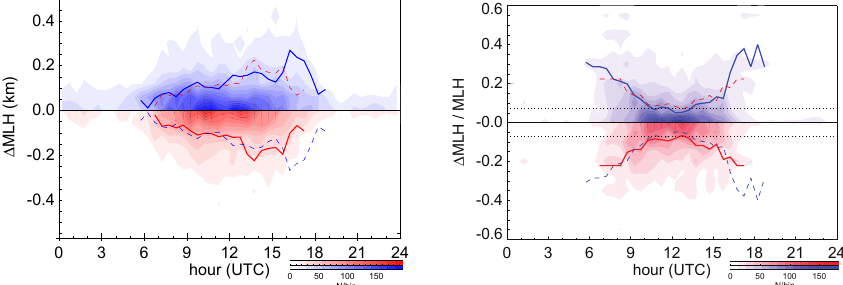
Figure 2. Absolute change 1 MLH=MLH ± − MLH 0 . 4 (left) and relative change 1 MLH / MLH 0 . 4 (right) of retrieved MLH ± for σ w ts =(0.4 ± 0.1)ms − 1 as a function of time of the day. Shading gives the histogram for single retrievals with σ w ts increased (red) and decreased (blue). Bin size is 30min, 60m absolute and 0.05 (5%) relative MLH change. Solid lines are half hour medians for increase (red) and decrease (blue) of σ w ts , respectively. Dashed lines are medians mirrored at zero. A total of 8667 (11218) records have been used for the upper (lower) histograms. During daytime there are on average 440 out of 540 points per half hour interval. Medians are not shown for times when less than 20% of the original data gave an estimate. Horizontal black dotted lines indicate the ± 7% change derived from the σ w profile of Lenschow et al.